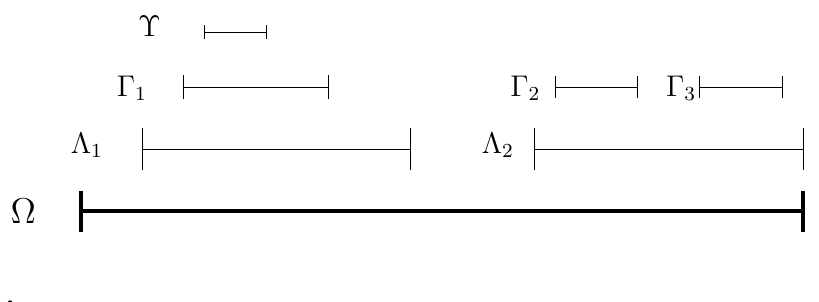
Figure 2. A diagram of several nested small-scale systems of a domain Ω